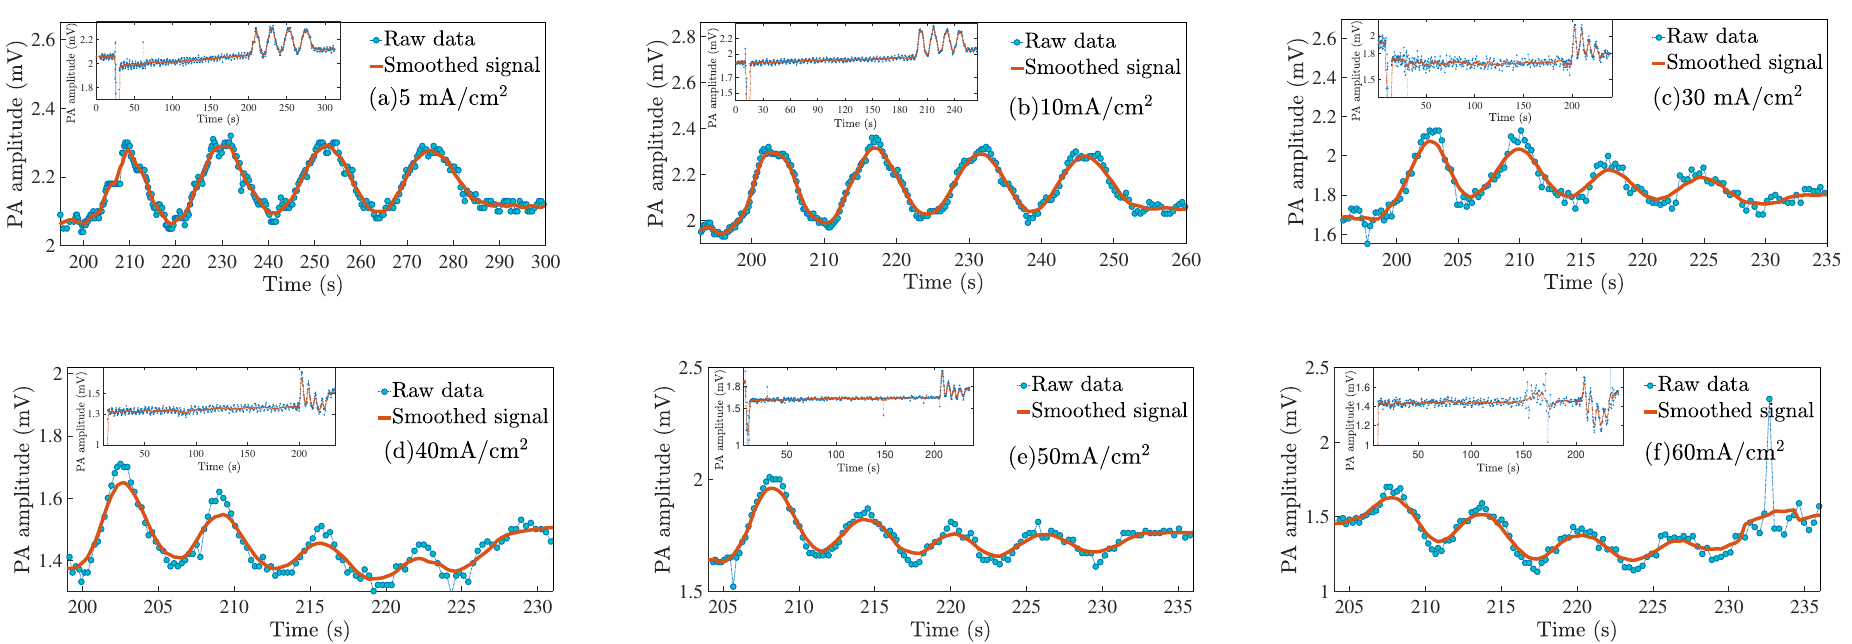
Figure 4. Show the in situ photoacoustic amplitude recorded during the etching process. Each graph corresponds to a specific current density for the samples summarized in Table 1. The PA amplitude changes periodically when the current injection is on. The insets show the complete anodizing